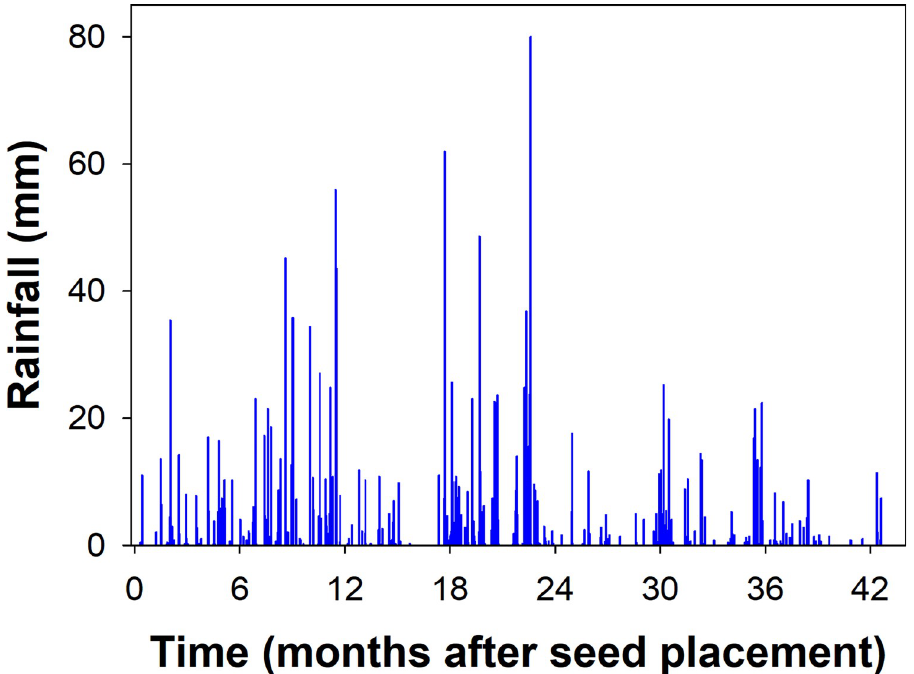
Fig 1. Rainfall (mm) at Gatton during the seedbank persistence study. Seeds were placed in the field in April